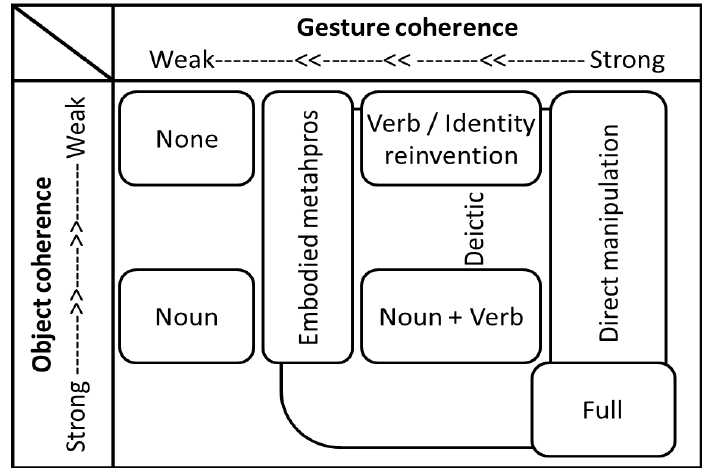
Figure 4. Map of tangible gesture semantic constructs.